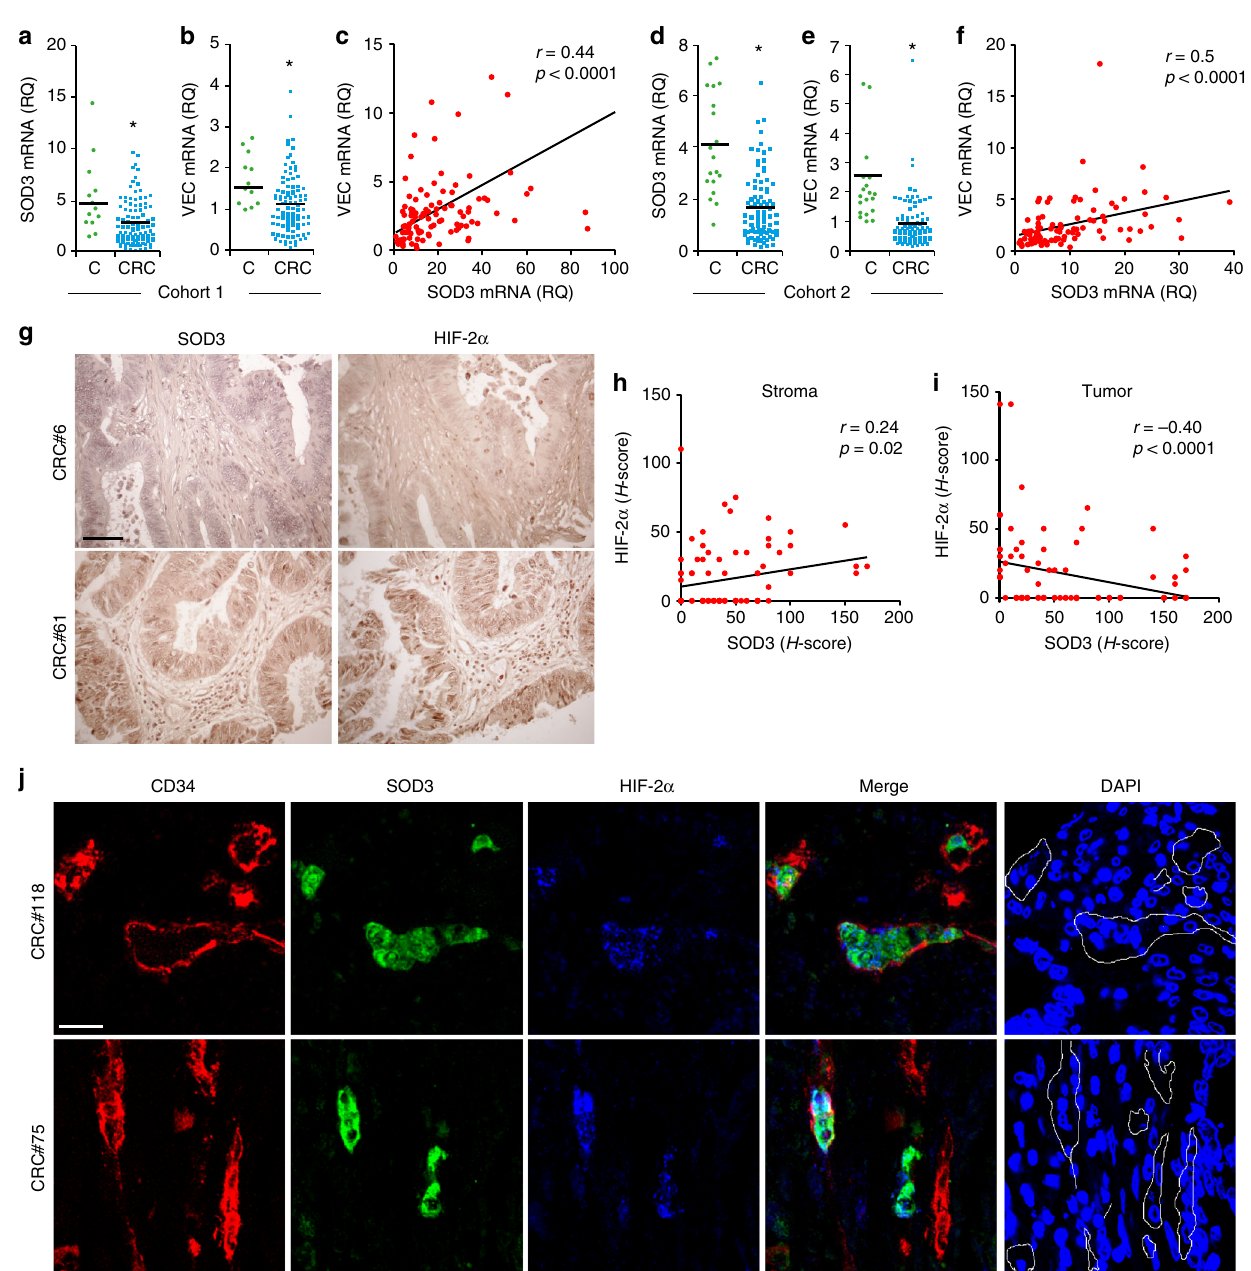
Fig. 8 Coregulation of SOD3, VEC, and HIF-2 α in primary CRC tumors. a , b Scatter plots showing individual data points and mean for SOD3 ( a ) and VEC ( b ) mRNA levels in non-tumor (C; n = 13) and CRC samples (CRC; n = 102). c Correlation of SOD3 and VEC mRNA levels in the CRC cohort. d , e Scatter plots as above for SOD3 ( d ) and VEC ( e ) mRNA levels in a validation cohort of 19 non-tumor and 87 stage III CRC samples. f Correlation of SOD3 and VEC mRNA levels in the CRC validation cohort. g TMA samples stained for SOD3 and HIF-2 α , representative of low (#6) and high (#61) SOD3 levels. h , i Correlation of estimated H -scores for SOD3 and HIF-2 α in stromal ( h ) and tumor ( i ) compartments. j Representative images from two tumor samples stained for CD34 (red), SOD3 (green), and HIF-2 α (blue); the three-color merge is shown; nuclei were counterstained with DAPI (see Supplementary Fig. 11 for single-color images). White lines in the DAPI panel contour CD34-stained areas. c , f , h , i Spearman ’ s rank correlation test; a , b , d , e * p < 0.05, two-tailed Student ’ s t -test. Bar, 50 μ m ( g ) and 20 μ m ( j